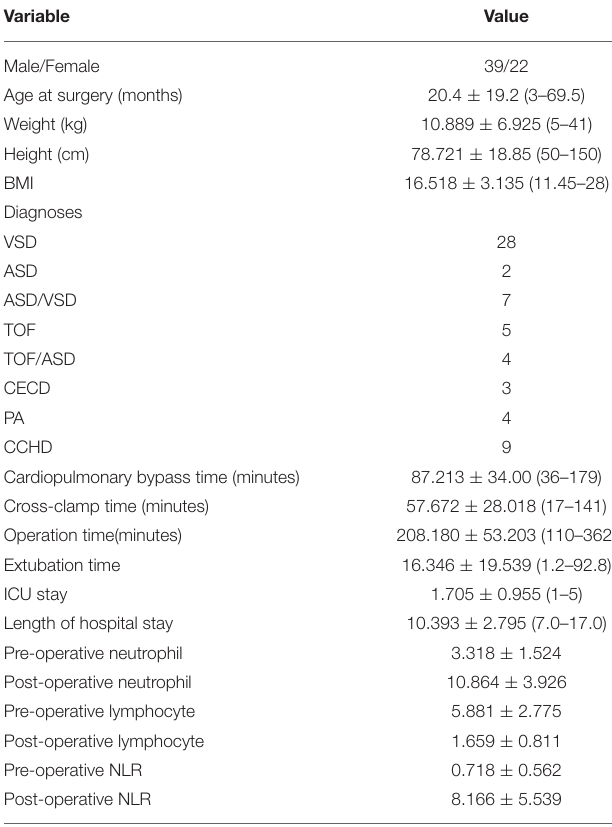
TABLE 1 | Baseline characteristics and clinical